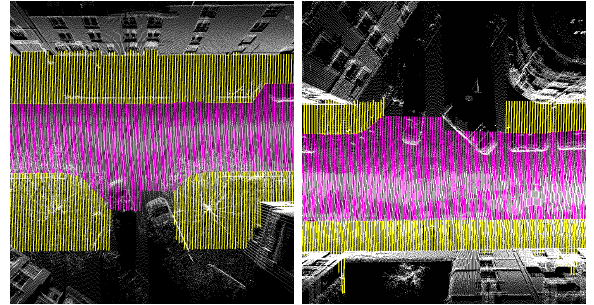
Figure 16: Crossroad areas.